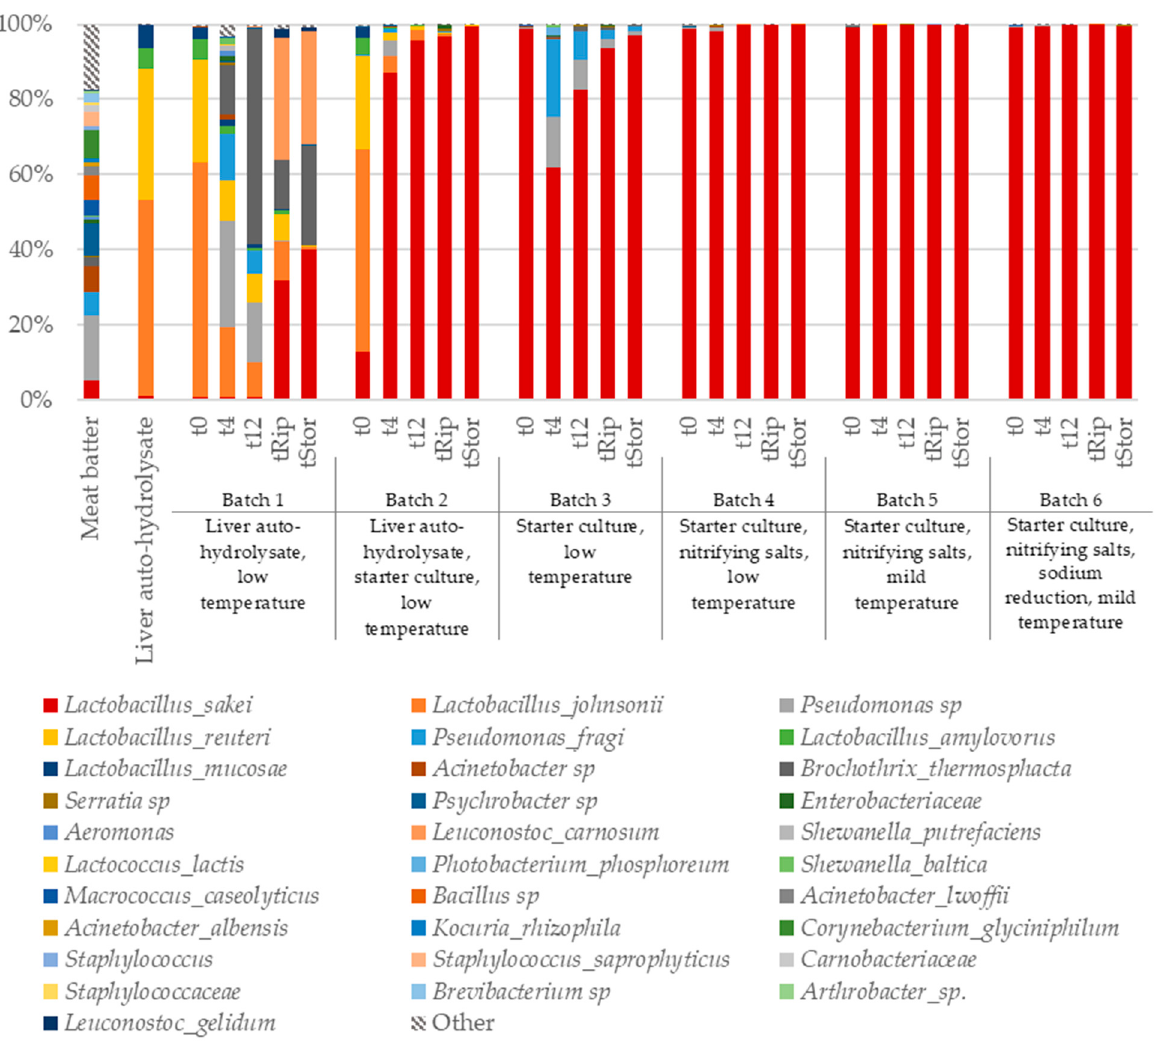
Figure 1. Taxonomic composition represented in the relative abundance (%) of microbial communities at the species level identified in the meat batter, liver hydrolysed ingredient and DFS batches (1, 2, 3, 4, 5 and 6) by time (days) 0, 4, 12, end of ripening and end of storage. Only species with an incidence above 1% in at least one sample are represented; the remaining are classi fi ed as “Other”.